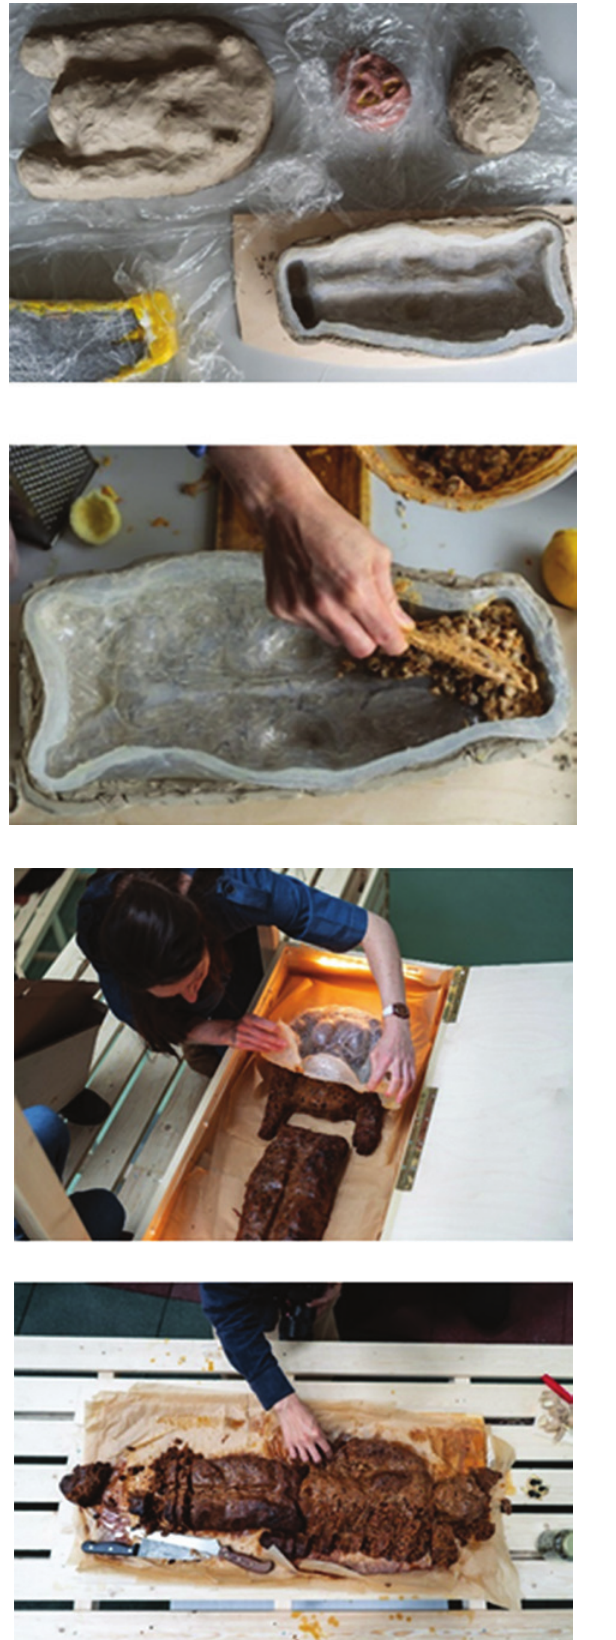
figure 3: Natasha Rosling, ‘Body cake’ (process), It Happens Anyway ,